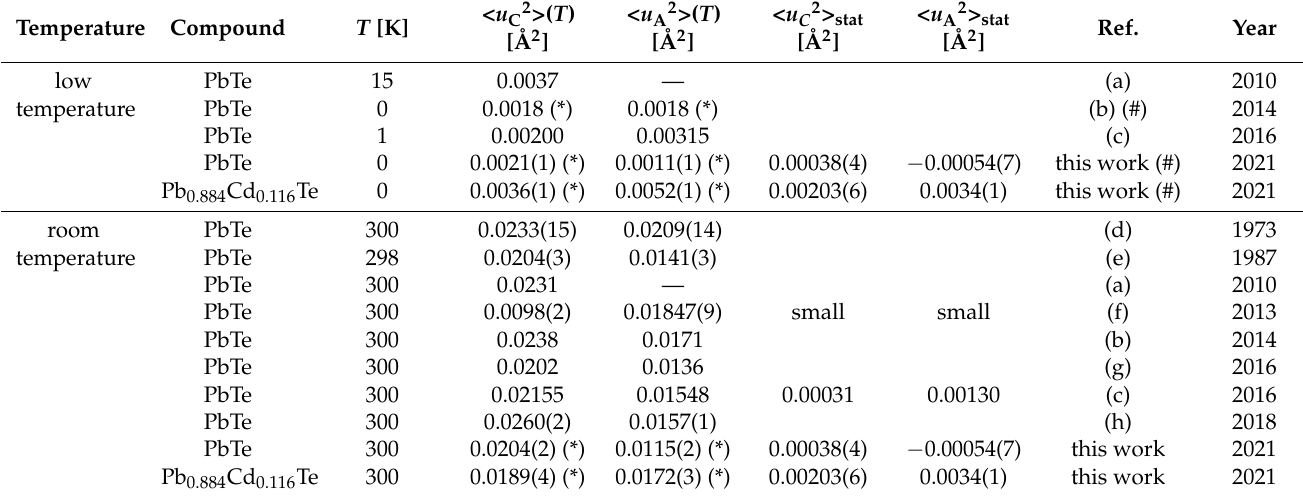
Table 9. Present and selected reported experimental values of the mean square cationic and anionic displacements, < u C2 >( T ) and < u A2 >( T ), respectively, near 0 K and at room temperature for PbTe and Pb 1 − x Cd x Te ( x = 0.116). The (independent on temperature) static components, < u C 2 > stat and < u A2 > stat , are provided, where available. For detailed numerical data of the present study, see Tables A1 and A2, Appendix